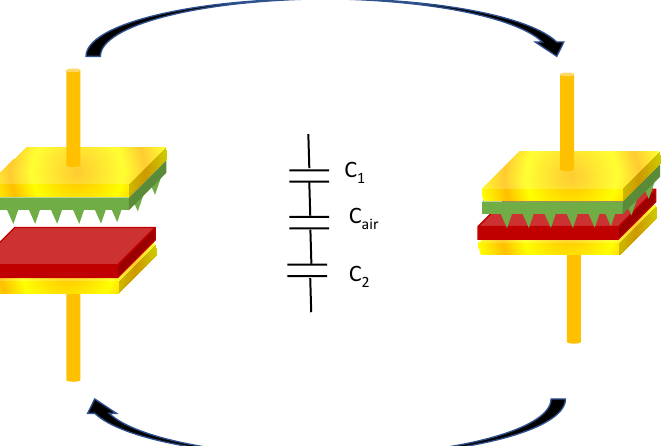
Figure 1. Schematic representation of triboelectric nanogenerator (TENG) composed of gold elec- trodes and two dielectrics (rough layer in green and a second polymer layer in red) and a repre- sentation of a corresponding electrical circuit.